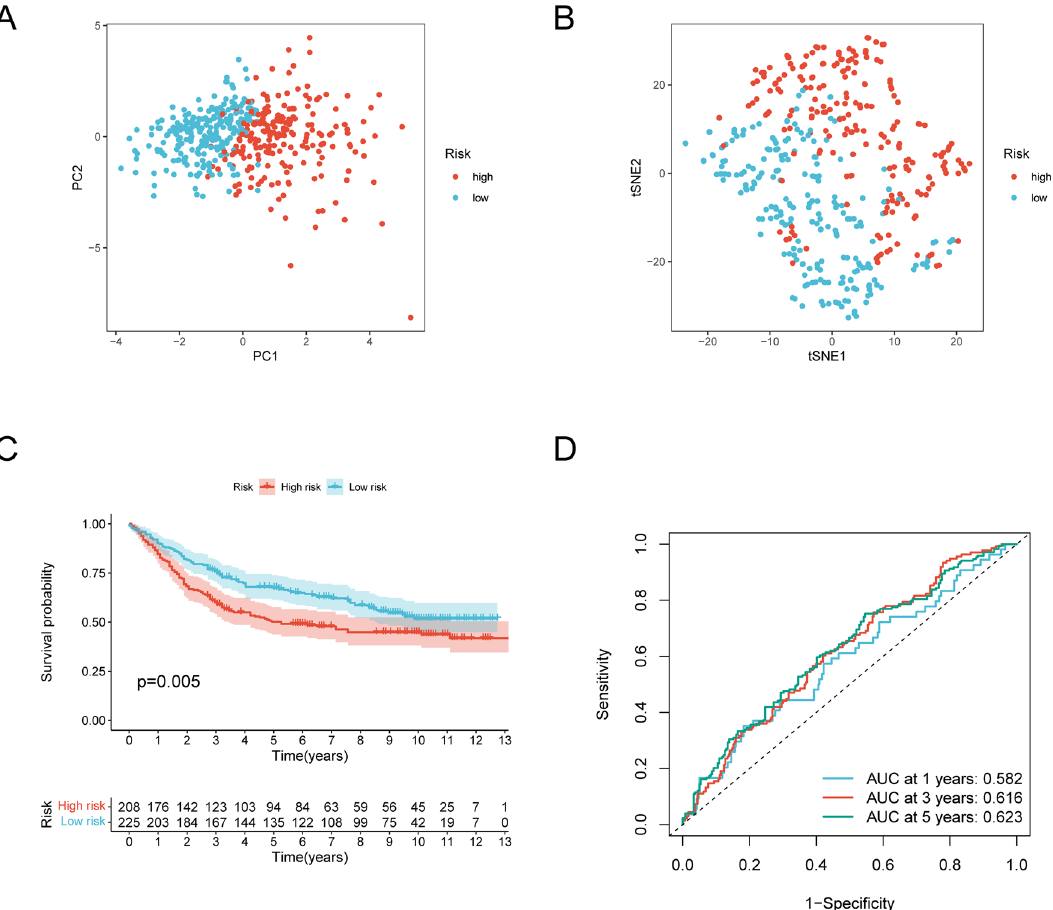
Figure 7. Validation of the necroptosis-related prognostic signature in the GSE84437 cohort. ( A ) Principal component analysis plot. ( B ) T-distributed neighbor embedding plot. ( C ) Kaplan–Meier curves (Log-rank test, P = 0.005) for OS of high- and low-risk groups. ( D ) The AUC of the prediction of 1, 3, 5 ‐ year survival rate of GC. OS, overall